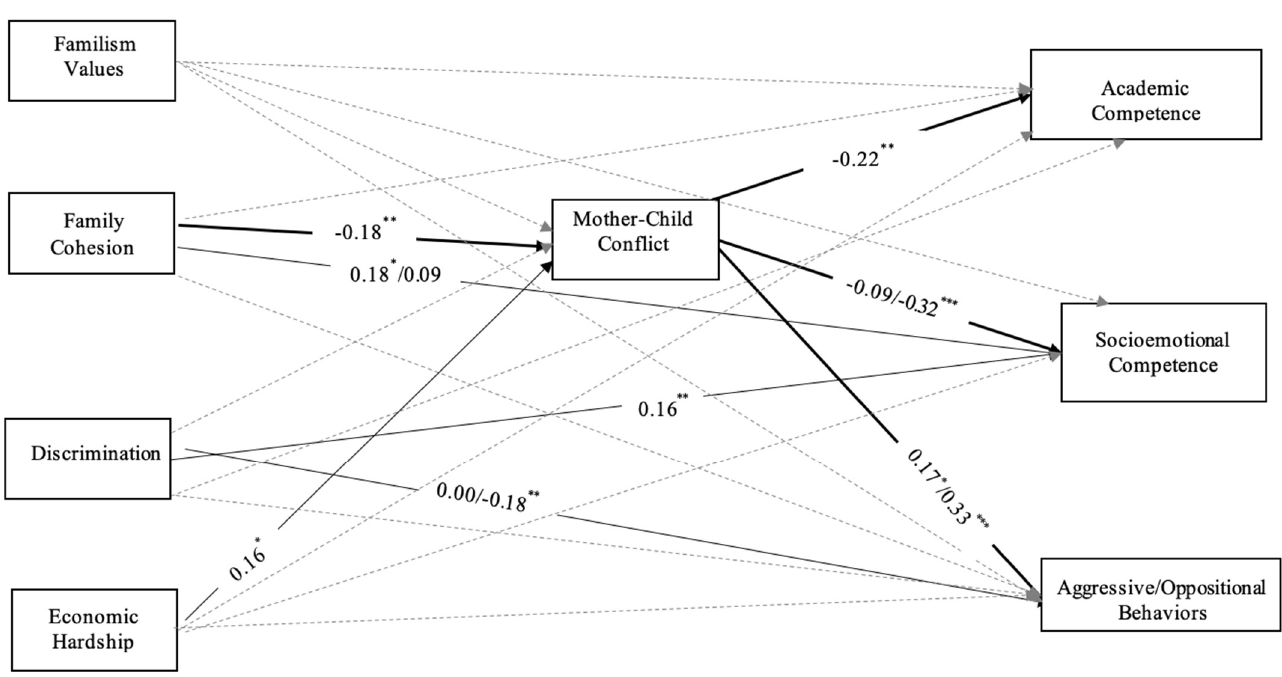
Figure 2. Mothers’ Cultural Assets and Challenges and Children’s Educational Adjustment via Mother–Child Conflict. Note. Standardized parameters are reported. For paths that differed by sibling birth order, parameters are reported for each group separated by the slash symbol (older sibling/younger sibling). Covariances, residual correlations, and covariates are not shown in the figure for parsimony. Solid lines represent significant direct effects. Bolded lines represent significant indirect paths. Dashed lines represent nonsignificant paths. * p < 0.05, ** p < 0.01, *** p < 0.001.